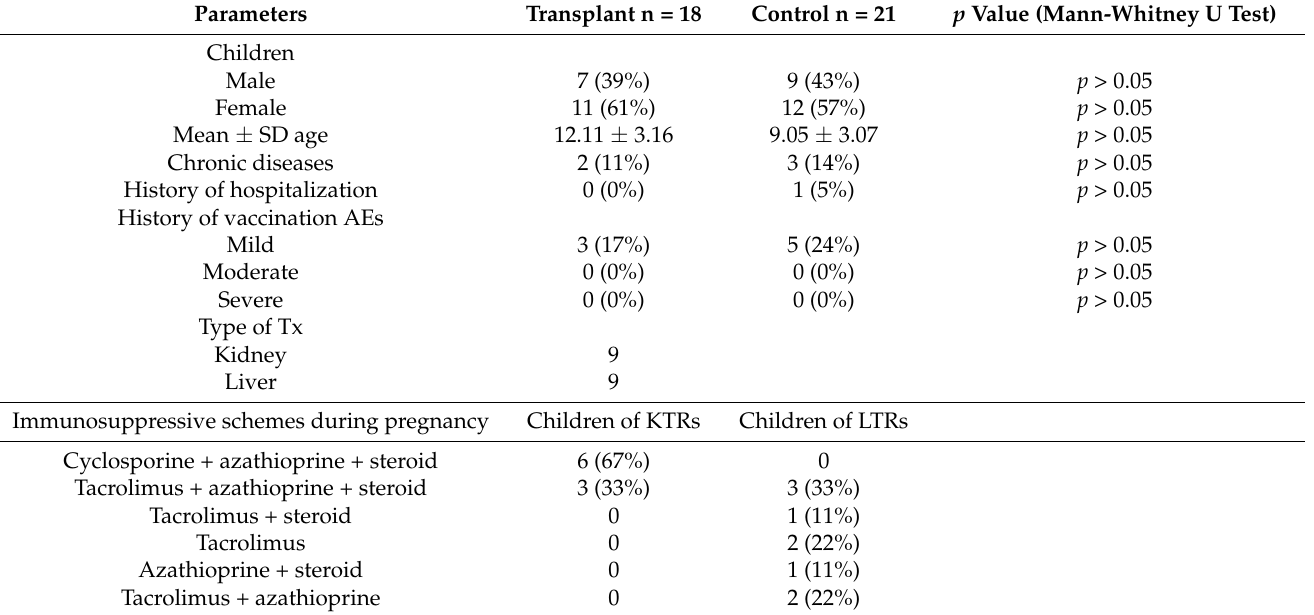
Table 2. Detailed description of the study and control groups.